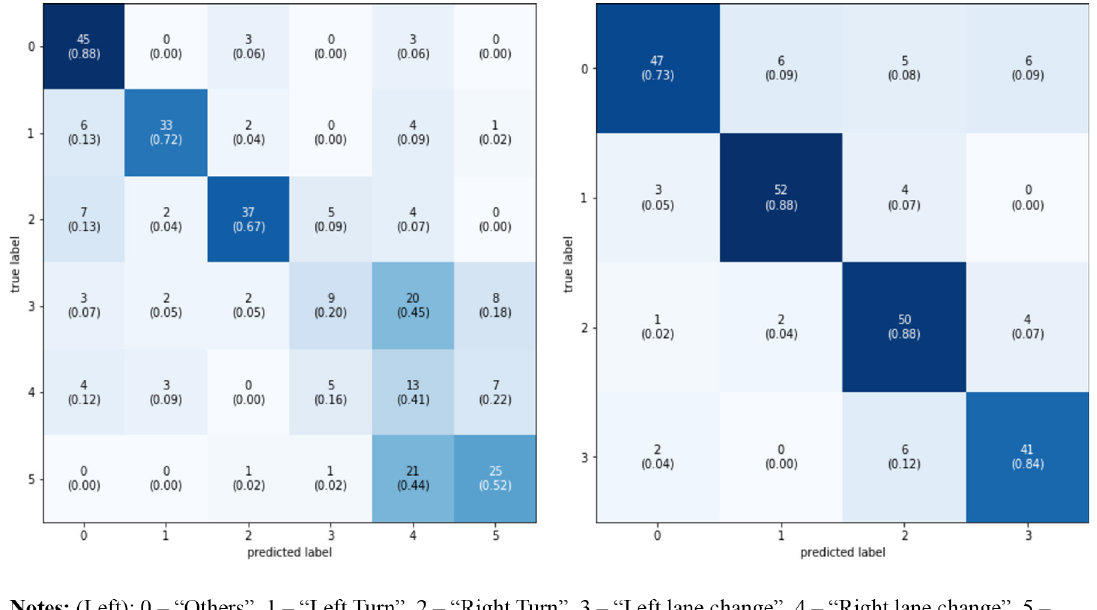
Figure 7 LSTM confusion